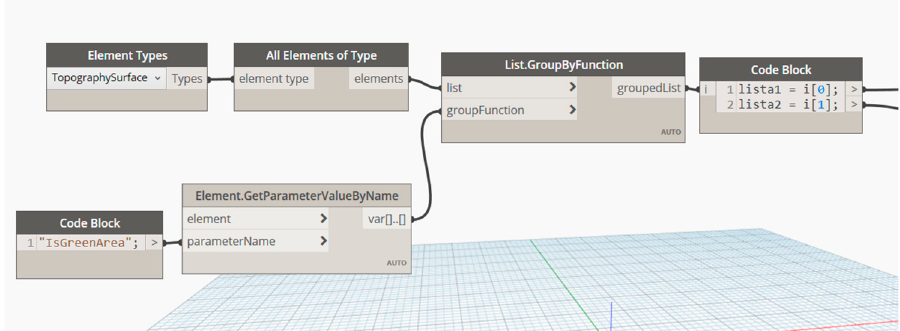
Figure 5. Information characterized into the Dynamo routine.